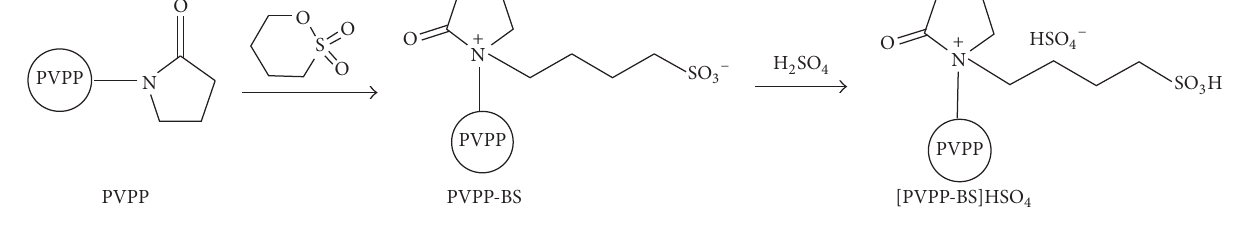
Scheme 1: Synthesis of [ PVPP-BS ] HSO 4 .